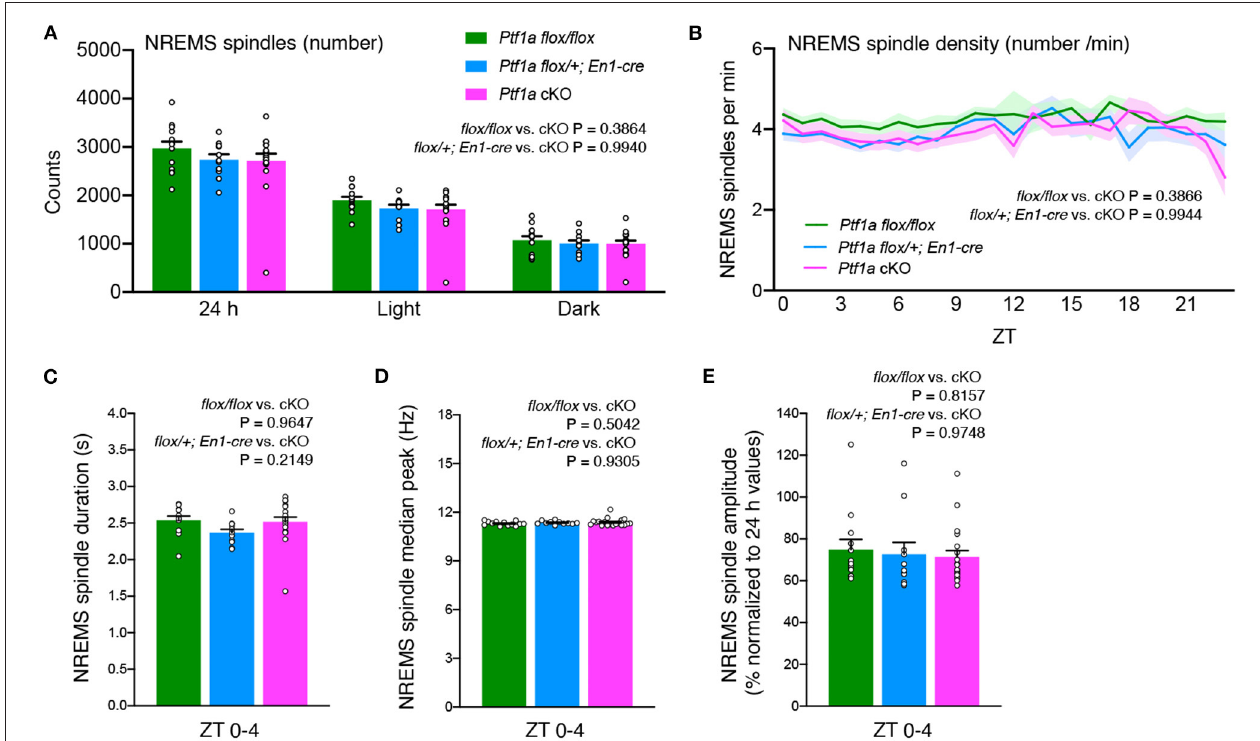
FIGURE 4 | No significant differences are observed in NREMS spindles of adult male Ptf1a cKO mice. (A) NREMS spindle number of Ptf1a cKO and control mice over 24h and during the light and dark phases under the basal condition. (B) Hourly NREMS spindle density (spindles/minute) over 24h in Ptf1a cKO and control mice.